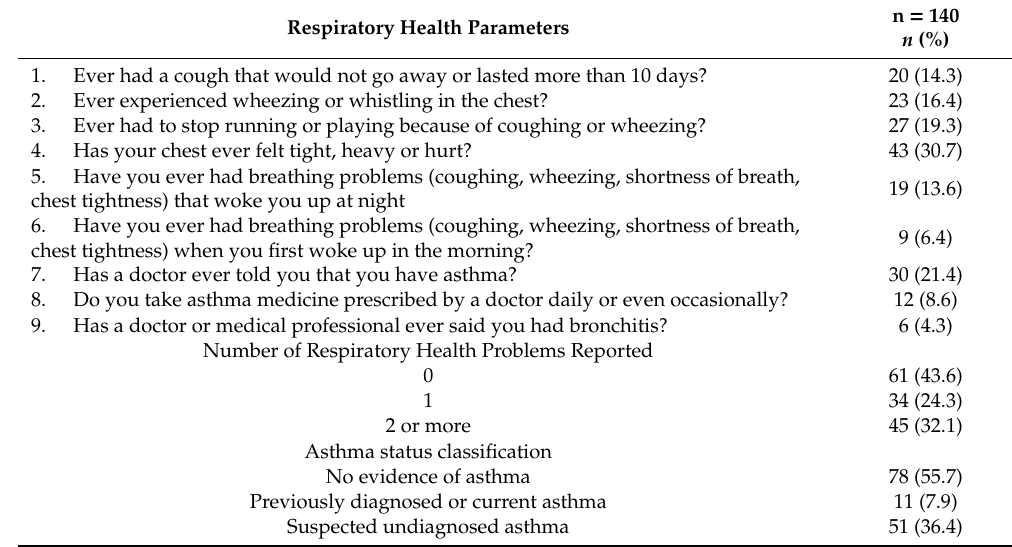
Table 2. Respiratory health questions, number of respiratory health problems and asthma status classification, hired Latinx child farmworkers in North Carolina,